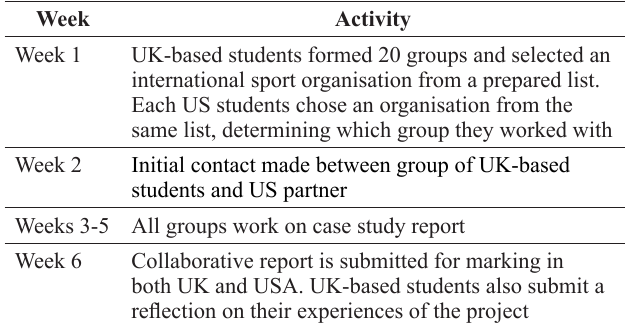
Table 1. Summary of Student